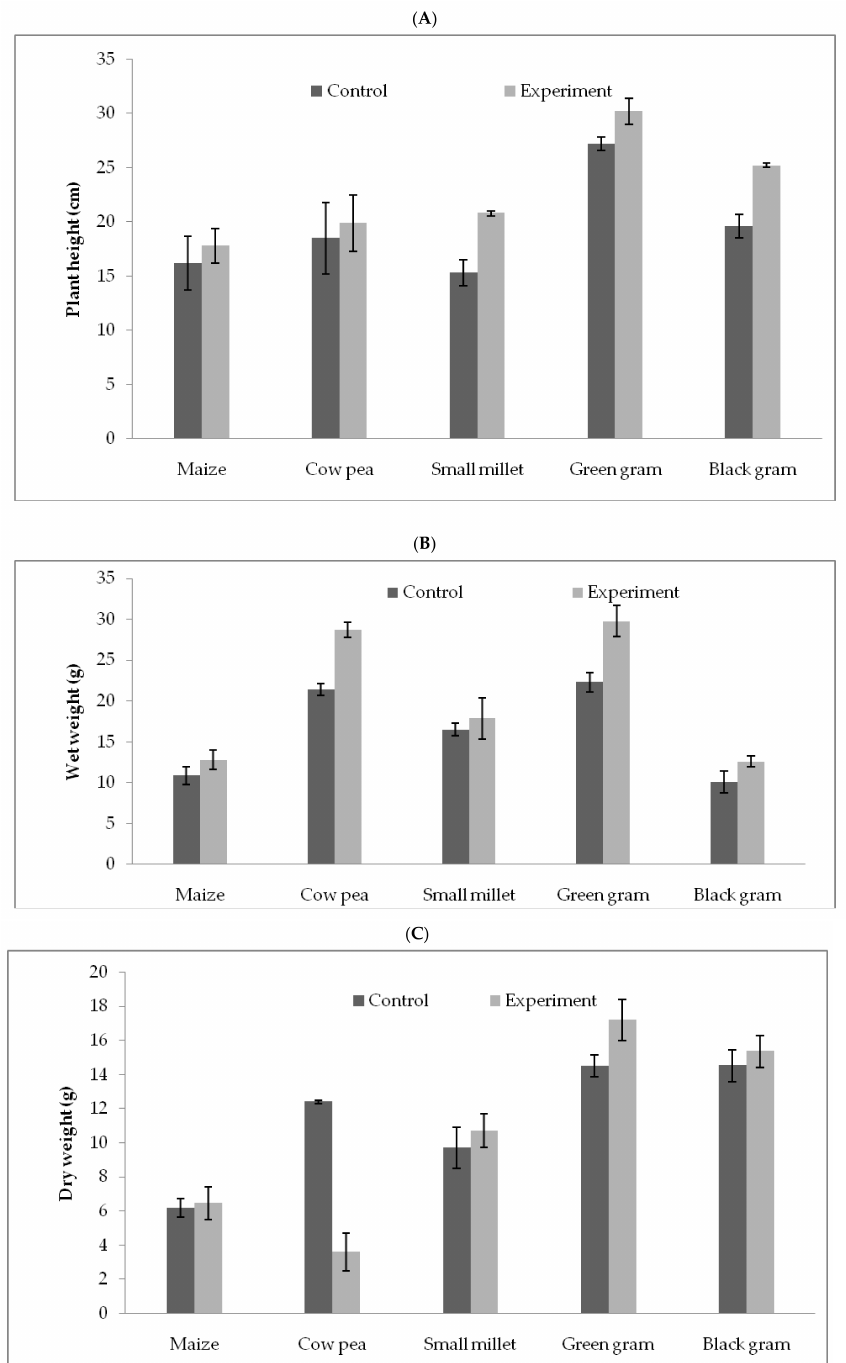
Figure 3. Effect of T. hamatum FB10 inoculated with maize, cowpea, small millet, green gram and black gram seedlings. Plant height ( A ), wet weight ( B ) and ( C ) dry